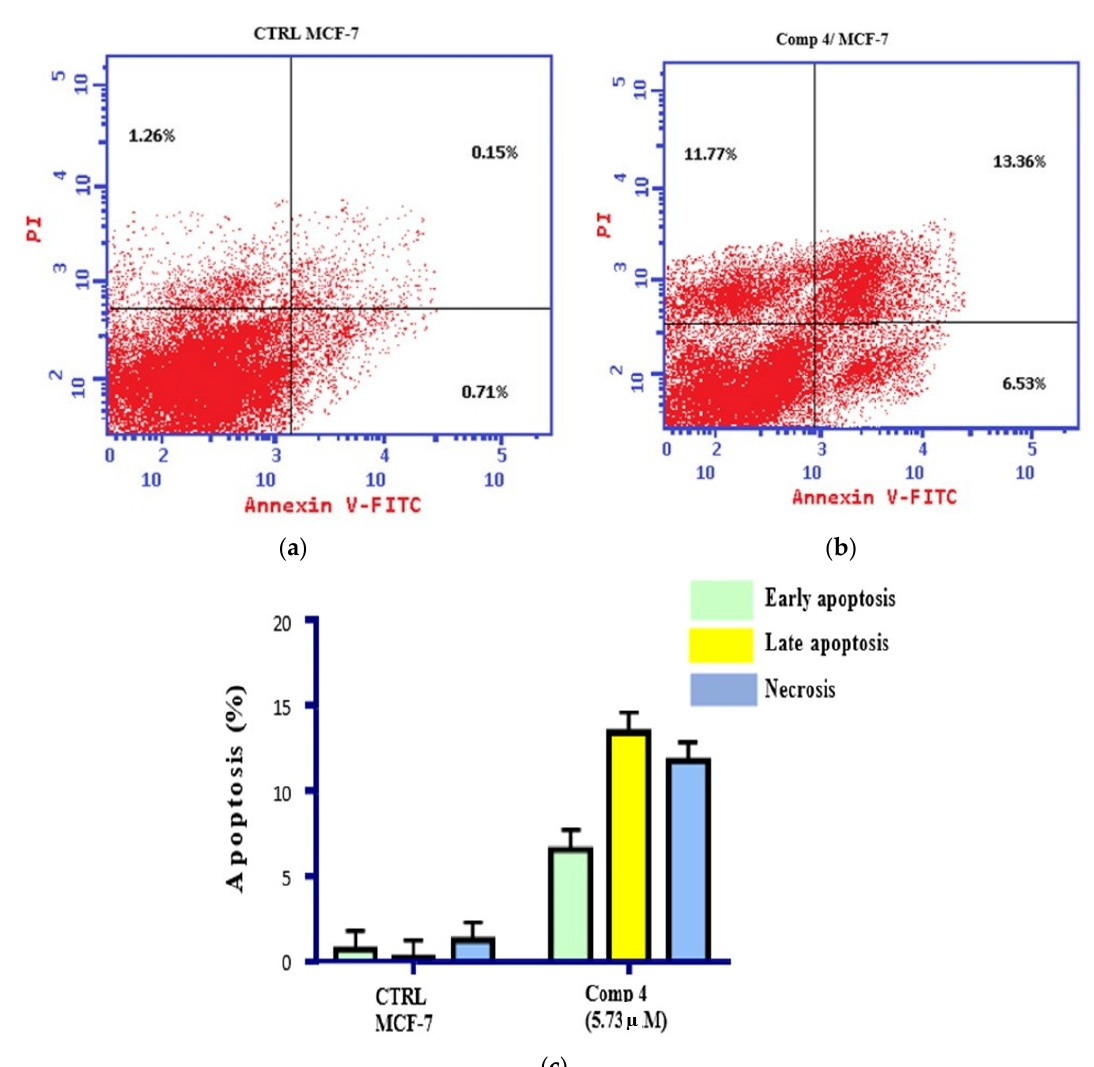
Figure 6. Effect of compound 4 on the programmed cell death of MCF-7 cells. ( a ) Cytofluorometry analysis of untreated MCF-7 cells using Annexin V FITC double labeling assay. ( b ) Cytofluorometry analysis of MCF-7 cells treated with compound 4 at 5.73 µM using Annexin V FITC double labeling assay. ( c ) Graphical representative analysis of the programmed cell death stages on the treated and untreated MCF-7 cells.